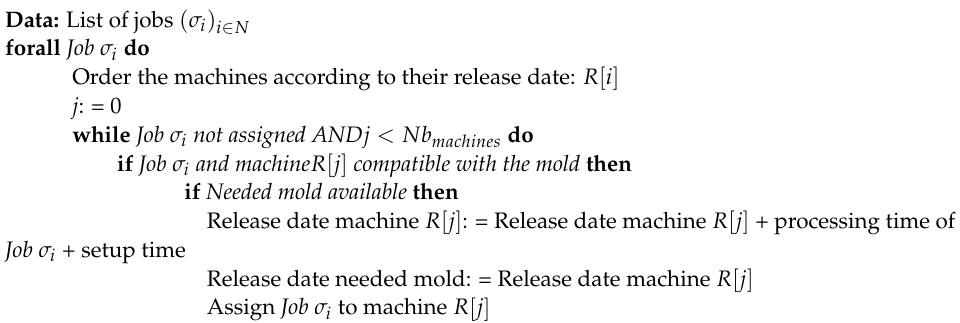
Algorithm 1 List algorithm for the injection